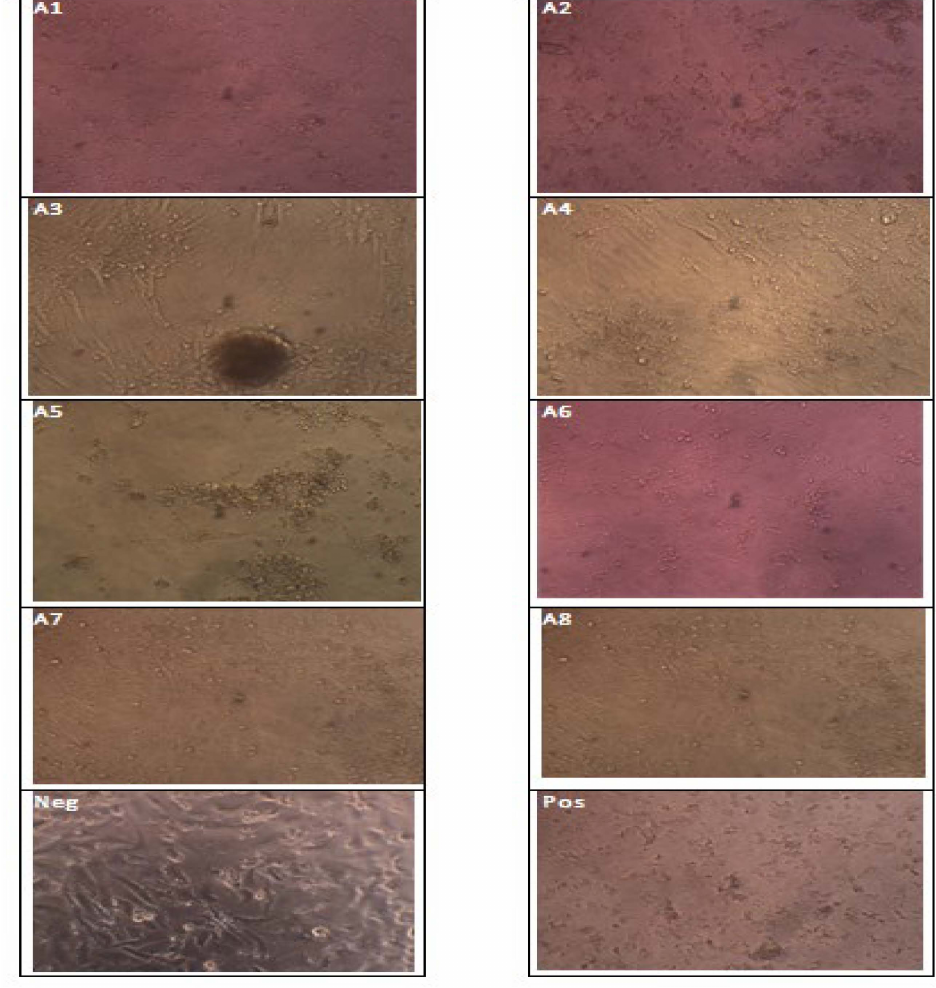
Figure 8. Effects of nanoparticles on the morphology of Vero cells after 14 days. A1 = 142, A2 = 284, A3 = 426, A4 = 568, A5 = 710, A6 = 852, A7 = 970, and A8 = 1000 are serially diluted nanoparticles. The negative control showed no change in morphology of the monolayer, whereas positive control cells were showing classical cytopathic